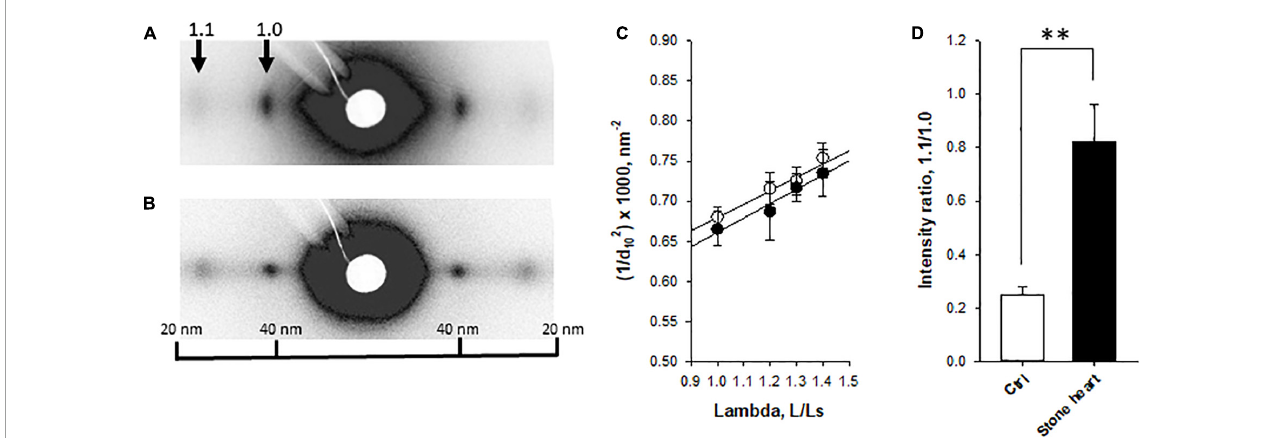
FIGURE3 Small angle X-ray diffraction of fresh control and stone heart samples. Panels (A,B) show original recordings from a control (A) and a stone heart (B) , with equatorial 1.1 and 1.0 reflections indicated. Panel (C) shows the spacing of the 1.0 reflection ( d 10 ) plotted as 1/ d 102 at different lengths ( L ) relative to slack length ( L s ). Straight lines were fitted to the relations. Panel (D) shows average 1.1/1.0 intensity at optimal stretch. Filled symbols and filled bars, stone heart; open symbols and bars, fresh hearts. N = 6–7 trabeculae in each group (from two animals in each group). ∗∗ p < 0.01.